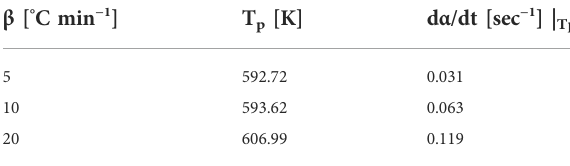
TABLE 2 Characteristics of DTG curves at different heating rates of G. pectorale pyrolysis. β [ ° C min − 1